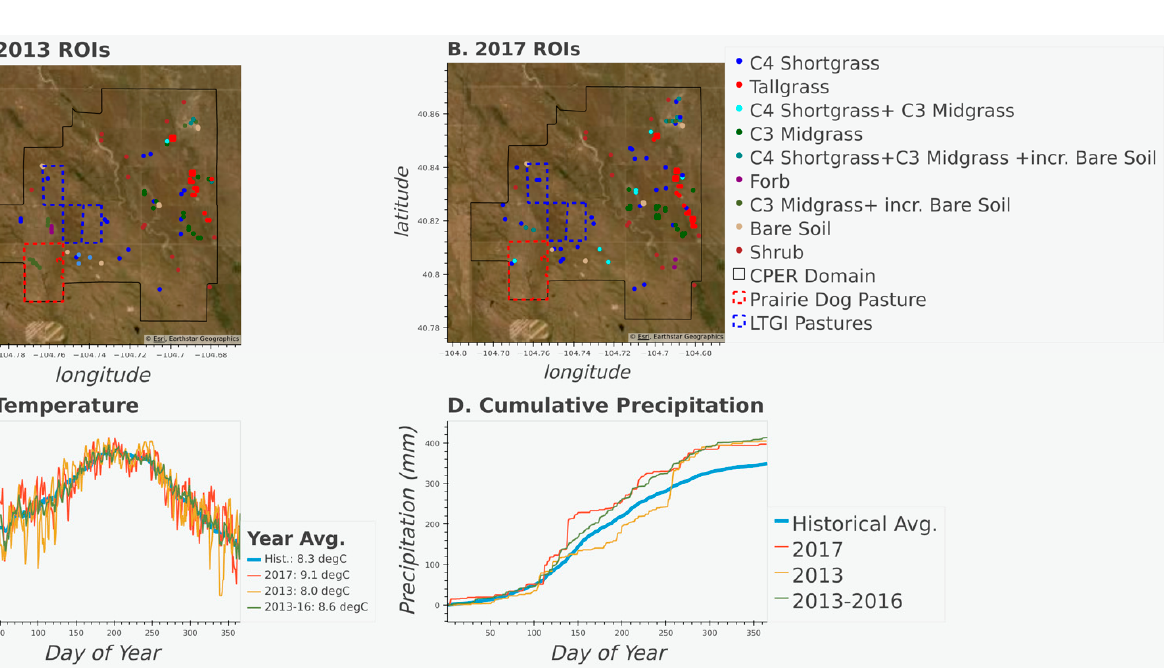
Figure 1. Maps displaying the aerial imagery of the study area, vegetation transect locations, pasture of interest (see Section 3.2), and CPER domain for 2013 ( A ) and 2017 ( B ). Time series of temperature ( C ) and cumulative precipitation ( D ) for 2013, 2017 and averaged values from 2013 to 2016, and the historical (1981–2020) record. Temperature and precipitation data from PRISM ANSI81.